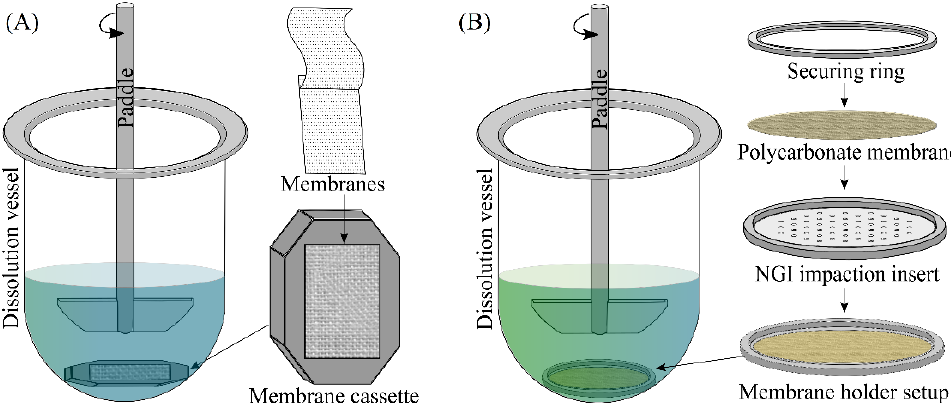
Figure 4. Schematic of paddle-over-disc apparatus with ( A ) membrane cassette, ( B ) NGI membrane holder. ( A ) reproduced with permission from Son and McConville 2009 [28], Elsevier. ( B ) reproduced with permission from Son et al., 2010 [50] Dissolution Technologies, Inc.